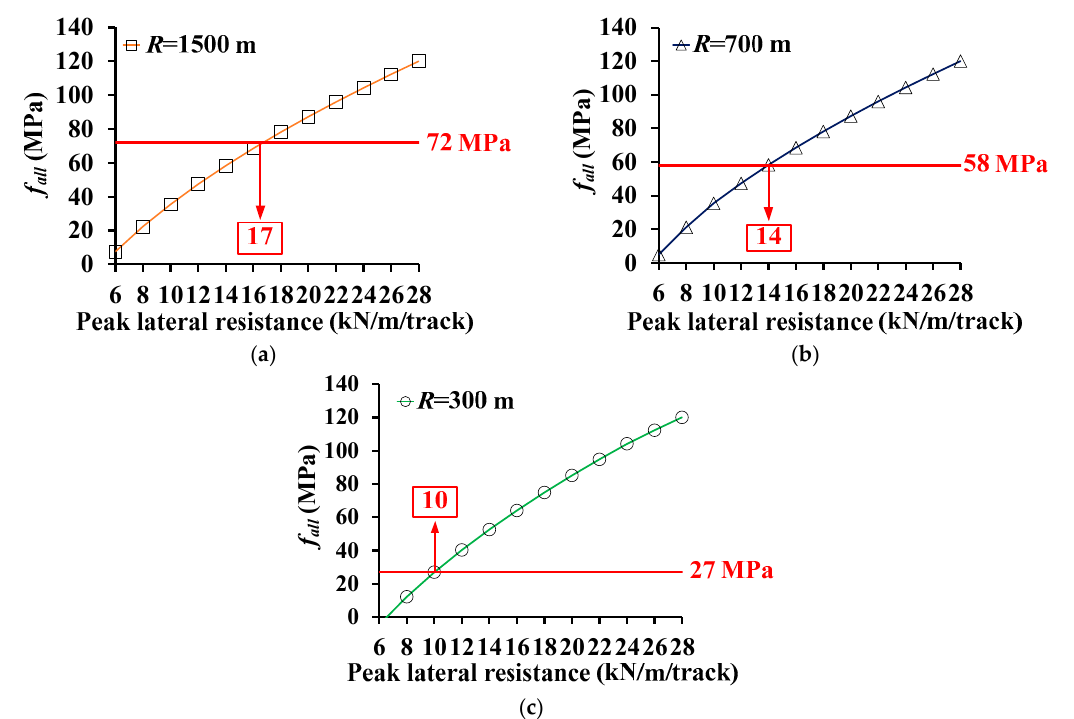
Figure 6. Theoretical evaluation of the min. lateral resistance: ( a ) R = 1500 m; ( b ) R = 700 m; and ( c ) R = 300 m.